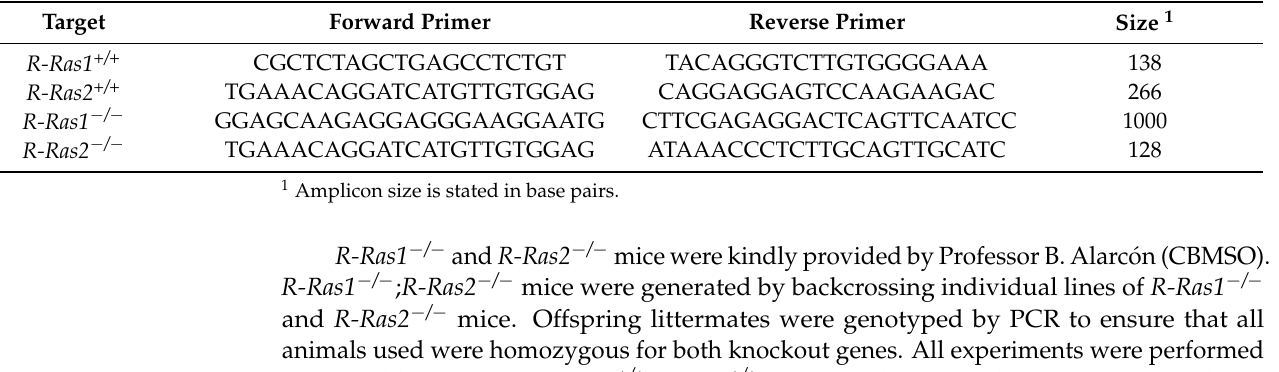
Table 1. PCR primer sequences used for murine colony genotyping. Primer sequences are stated from 5 (cid:48) to 3 (cid:48)